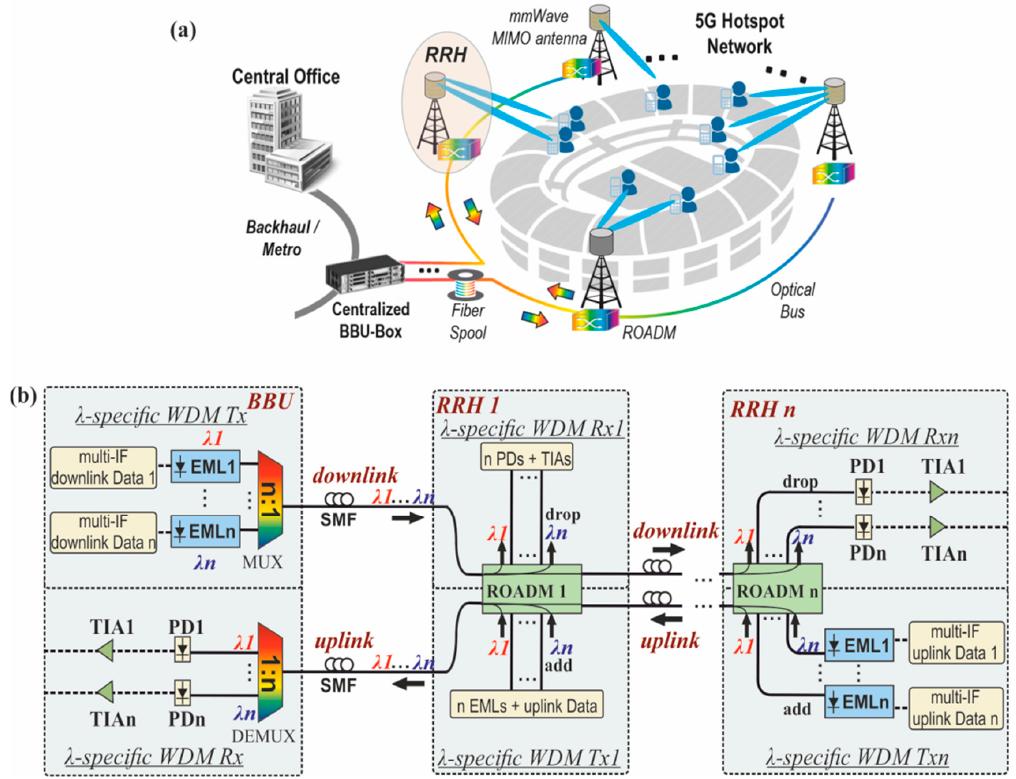
Figure 1. ( a ) Fronthaul architecture for serving a typical stadium area, where a number of buses is deployed. Each bus consists of a number of remote radio heads (RRHs), each one interconnected with a reconfigurable optical add-drop multiplexer (ROADM) through single mode fiber (SMF) wavelength division multiplexing (WDM) is also exploited. ( b ) Configuration of the baseband unit’s (BBU’s) and the RRHs’ WDM wavelength-specific TxRxs employed for the downlink communication between the BBU and the RRHs, and the uplink communication of the RRHs with the